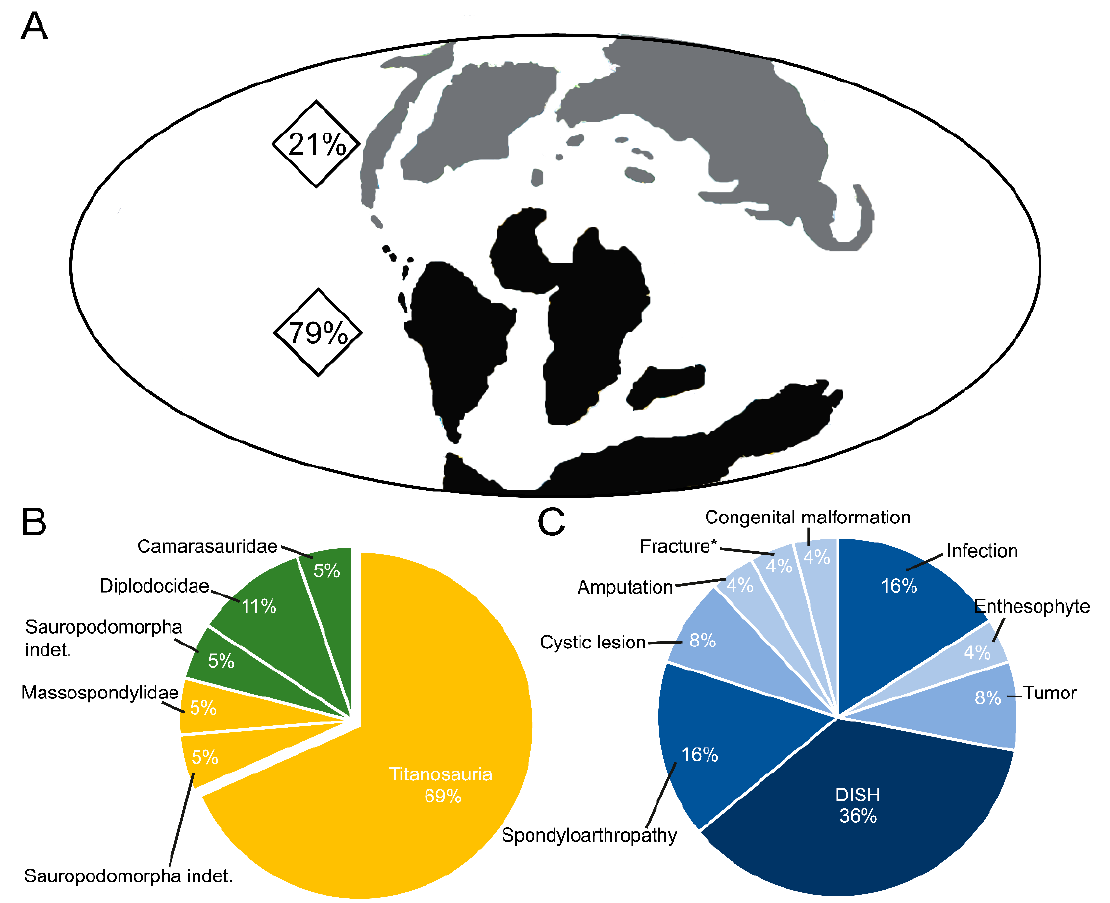
Figure 4. Distribution of pathologies associated with sauropod dinosaur tails: ( A ) percentage by supercontinents (Laurasia and Gondwana), ( B ) pie chart of the pathologies analyzed by clade, and ( C ) by disease. *, presence of fracture associated with a haemal arch.